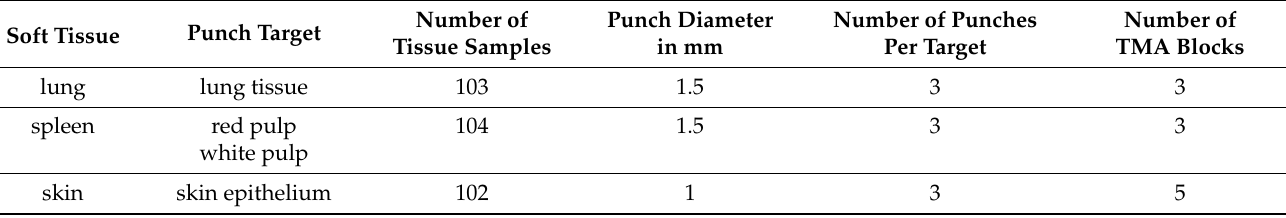
Table 5. Overview of the extracted soft tissue and the TMA punch